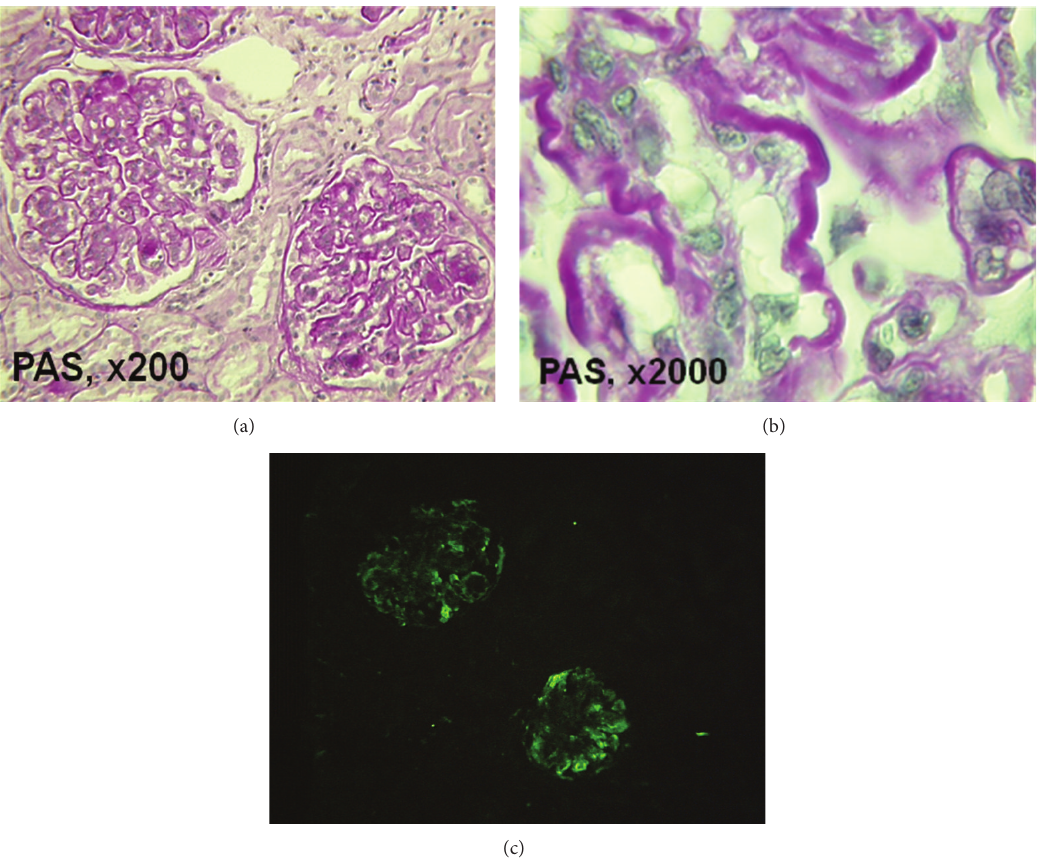
Figure 1: (a) Type II membranoproliferative glomerulonephritis characterized by mesangial matrix and cellular increases is responsible for a lobular accentuation associated with a diffuse and intense staining of the peripheral basement membrane (periodic acid-Schiff [PAS], magnification [G]: × 200). (b) The diffuse and intense staining of the peripheral basement membrane indicates the presence of dense deposit material (PAS, G × 2000). (c) Immunofluorescence techniques show segmental pseudo linear and granular IgM deposits along the peripheral capillary wall (fluorescein isothiocyanate anti-IgM, G ×